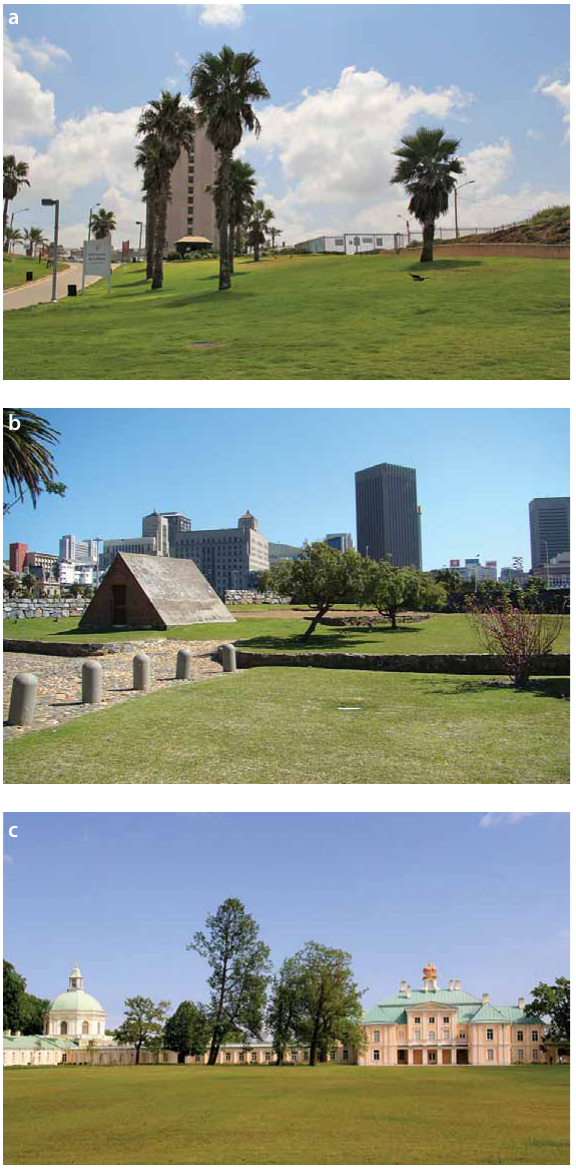
fig. 2. Global lawn pattern: a – Tel aviv (Israel), b – Cape Town (South africa), c – St. Petersburg